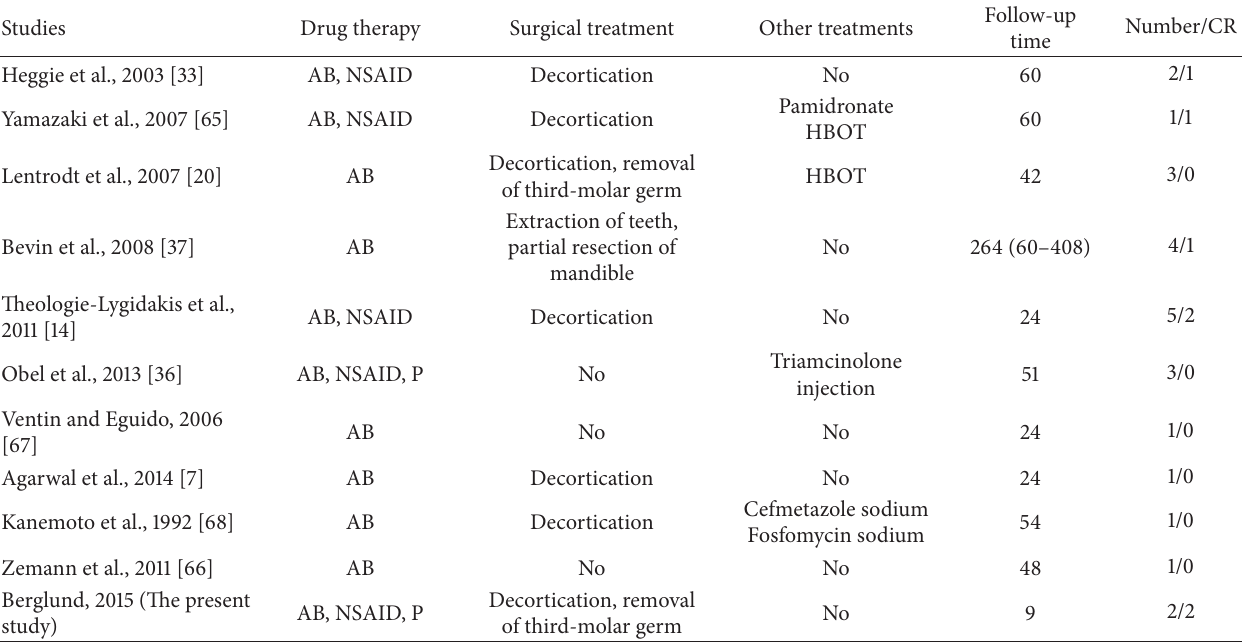
Figure 7: Six-month postoperative control radiographs, CBCT, and clinical image of patient case 2 with PCO. (a) Panoramic radiograph; (b) CBCT. Coronal section of the sclerotic collum mandibulae with lytic lesions; (c) patient photo, with reduced facial swelling at the right side; and (d) CT scan 3D model with bone thickness at the right side of the collum mandibulae. Table 2: Treatment strategies and